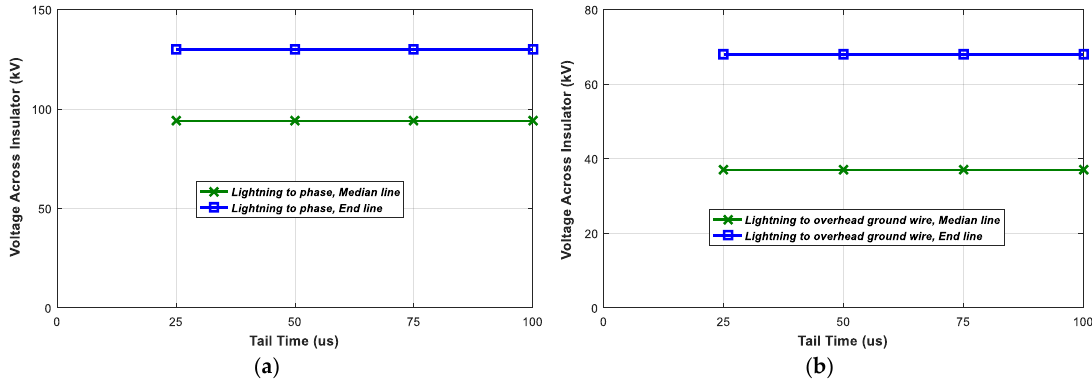
Figure 17. Voltage across the insulator for different tail time lightning current wave shapes (grounding distance of overhead ground wire = 200 m, ground resistance = 10 Ω, front time = 4.12 μs); ( a ) Strike to the phase conductor; ( b ) Strike to the overhead ground wire.